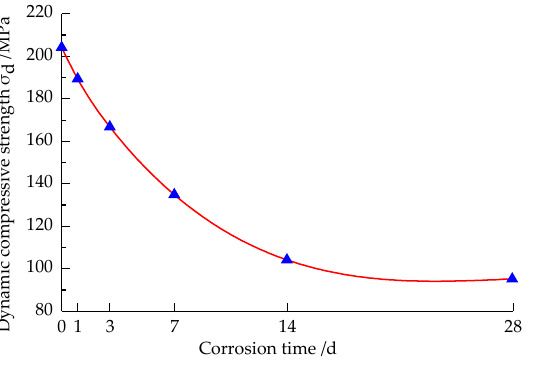
Figure 6. Variation curve of dynamic compressive strength with the solution corrosion time.